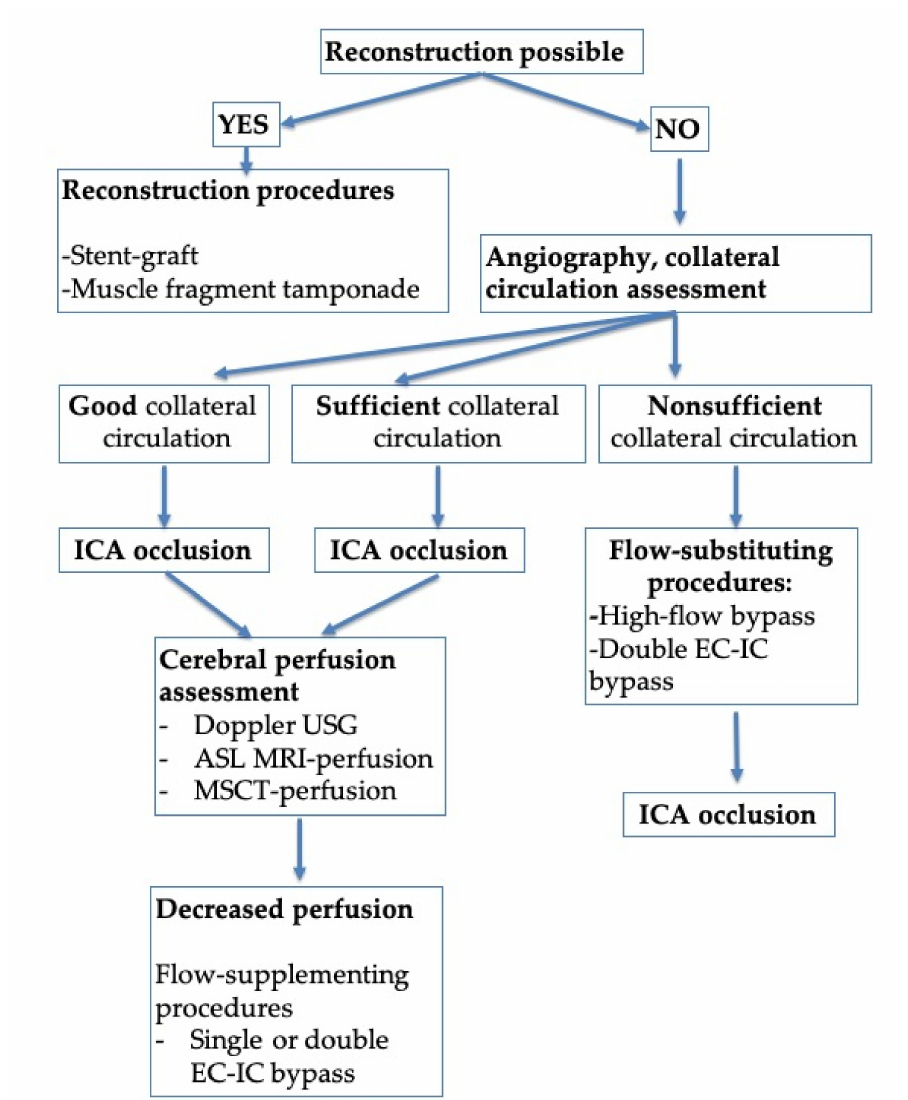
Figure 1. Treatment algorithm for patients with ICA injury (depending on anatomical features of the artery and potential for surgical reconstruction). Abbreviations: ASL MRI, arterial spin labeling magnetic resonance imaging; EC, extracranial; IC, intracranial; ICA, internal carotid artery; MSCT, multislice computed tomography; USG,